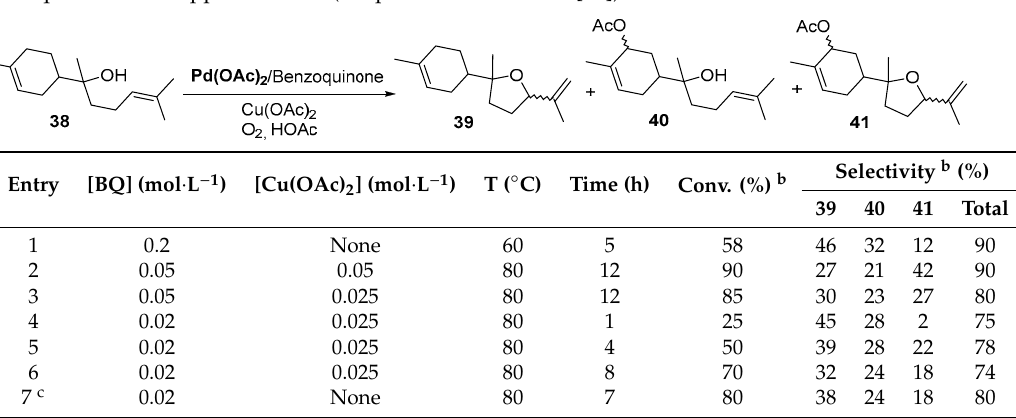
Table 14. Palladium-catalyzed oxidation of α -bisabolol 38 with molecular oxygen in the presence of benzoquinone and copper acetate a (adapted from reference [53]).